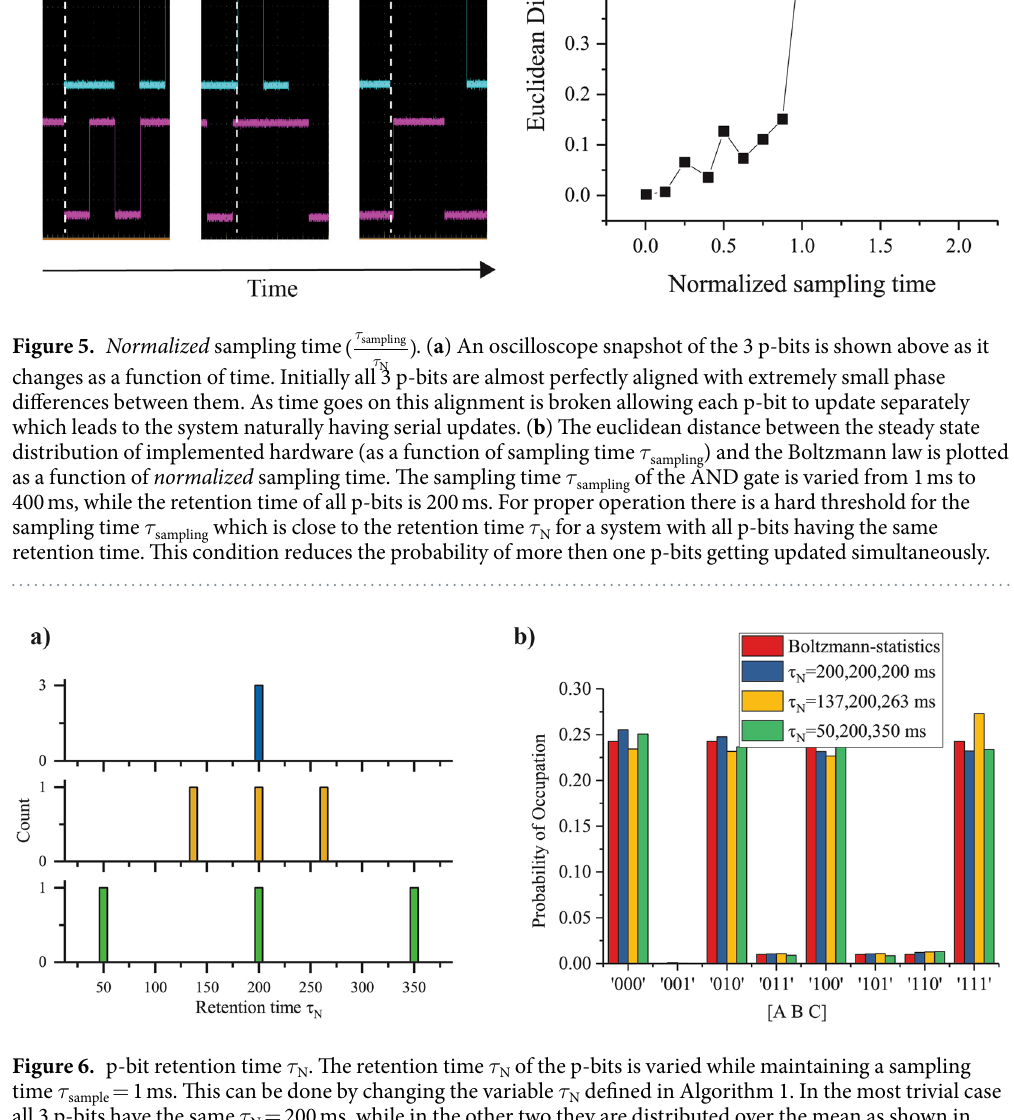
An essential requirement for Hopfield networks and unrestricted Boltzmann Machines is the need for sequen- tial updating, where each p-bit is updated serially but in any random order 8, 33 , as opposed to parallel updating where each p-bit is updated at once. To enforce serial updating in asynchronous networks in simulation requires control flow statements which regulate the updating procedure of p-bits to one by one. Serial updating arises nat- urally in our setup since each p-bit is completely independent of each other and small phase differences that are present initially get greatly magnified as the system is run for longer periods of time, in the absence of a central clock signal. This type of updating is also known as the “asynchronous dynamic” in Hopfield networks 33 . This is shown for an AND gate with 3 p-bits in Fig. 5(a), where each of the 3 p-bits are almost perfectly aligned to each other initially, however this alignment is broken as system continues to run with time. Asynchronous machines are known to converge slowly, while their synchronous counterparts allow for parallel updating, allowing much faster convergence. For hardware implementations, it is the synchronous Boltzmann Machines or Restricted